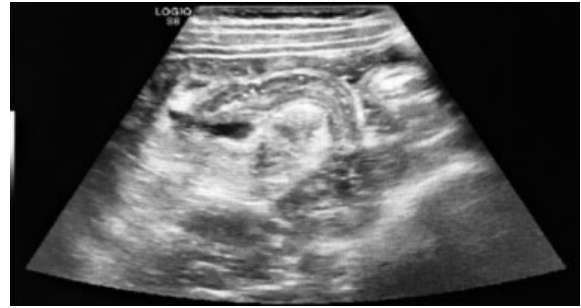
Fig. 2 Case 2: Initial abdominal ultrasound image (longitudinal view) showing telescoping of bowel into the bowel.